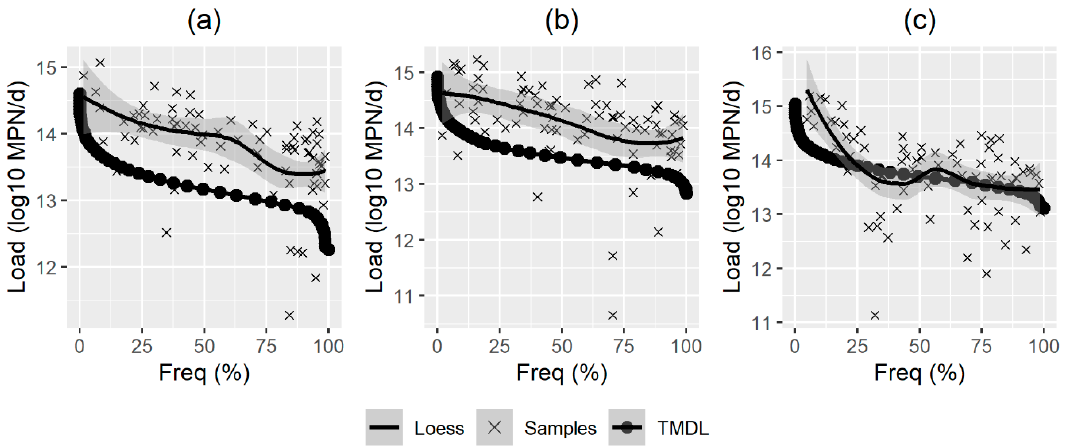
Figure3. Comparisonbetweenloaddurationcurves(TMDL)andLoesscurve(representingthetendency Figure 3. Comparison between load duration curves (TMDL) and Loess curve (representing the of E. coli samples) in the Piracicaba river basin for gauges: ( a ) RD025 / 56610000, ( b ) RD029 / 56659998 tendency of E. coli samples) in the Piracicaba river basin for gauges: ( a ) RD025/56610000, ( b ) and ( c ) RD031 / RD029/56659998 and ( c ) RD031/56696000.